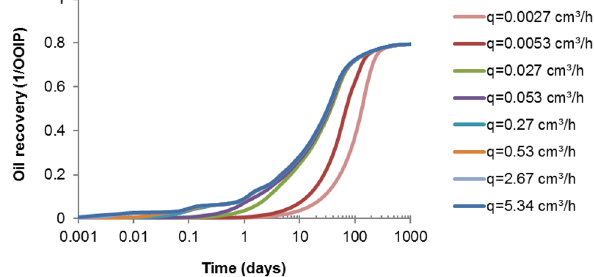
Fig. 11 Ultimate oil recovery after injecting 2 PV surfactant solution with different injection